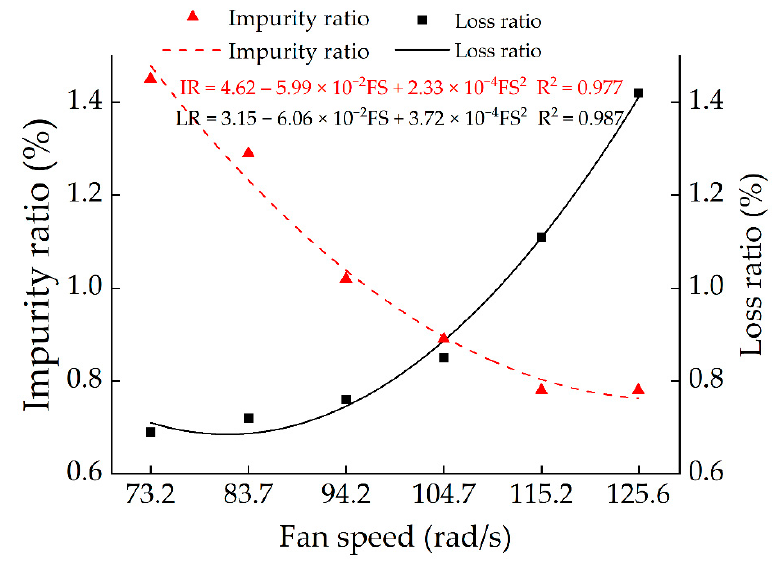
Figure 6. Influence of fan speed on the impurity ratio and loss ratio.